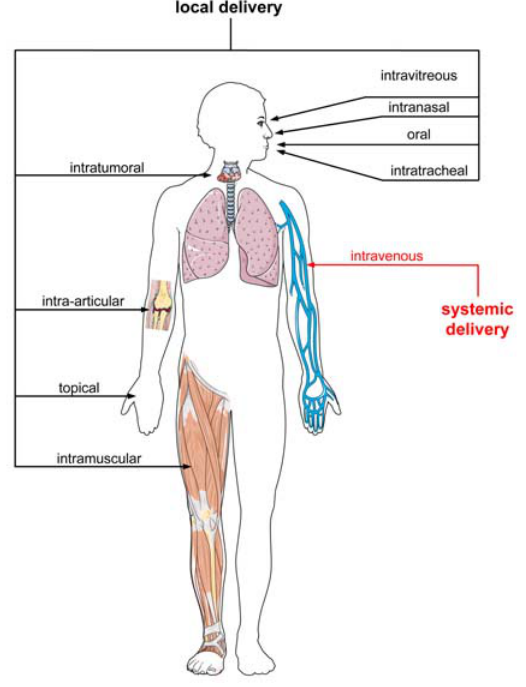
Figure 4. Possible routes for in vivo nucleic acid administration. Shown are local and systemic administration schemes. This figure was produced using Servier Medical